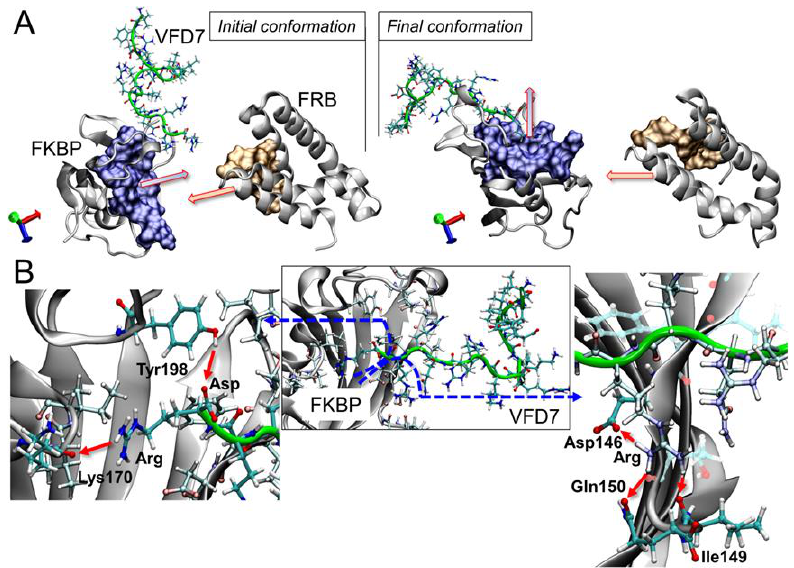
Figure 6. FKBP rotation promoted by the VFD7-cpp peptide. ( A ) shows the misalignment of the FKBP – FRB interfaces; expected contact residues are highlighted on the surface according to the previous study [4], and ( B ) shows the hydrogen interactions which attach the peptide close to FKBP binding interface.